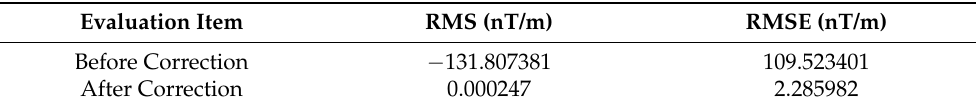
Table 3. Comparison of statistical characteristics before and after DA–LM correction.